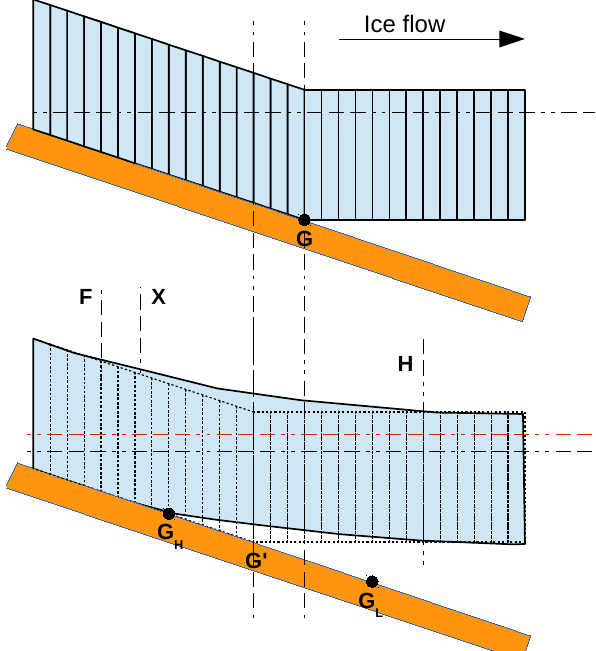
Figure 3. Ice–ocean interactions near the grounding line. The top of the figure represents the grounded–floating transition for an outlet glacier where hydrostatic equilibrium with a constant “non-tidal” ocean is assumed throughout. The lack of rigid stresses is here il- lustrated by blocks floating independently from one another. The floatation criterion allows a first estimation of the contact point G. The situation as depicted at the top is supposed to represent an average sea level between low and high tides. The bottom of the figure now considers the effects of the tidal rise (red line) super- posed on top of the previous reference state. Should the response remain purely hydrostatic, tidal deformation would only span the G–G 0 distance, therefore representing an underestimated migration of the grounding line. In fact, the tidally short-term forcing implies a rigid behaviour, making the deformation spread over the entire grounding zone (FH), now implying a more realistic migration for the grounding line. As a result, ice surface movements are to be ex- pected from F and will become detectable after a certain distance seaward (at point X) depending on the detection threshold of the kinematic method